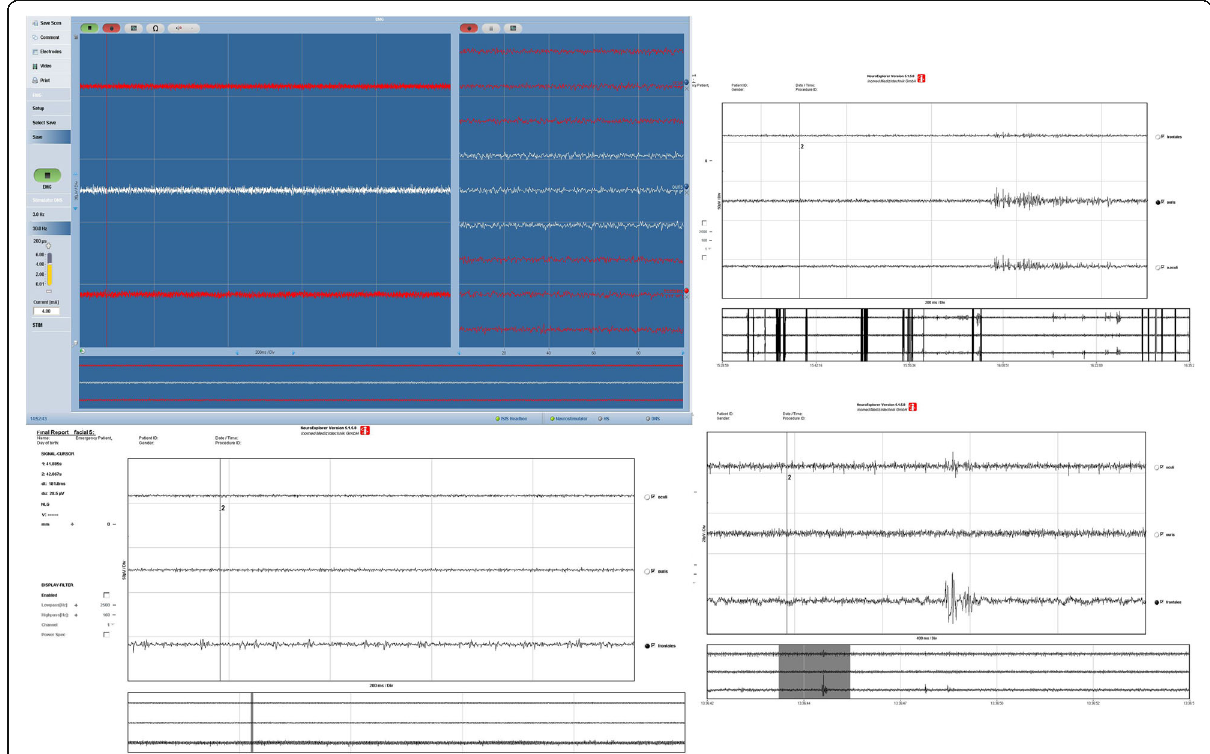
Fig. 3 Train and burst responses: single or